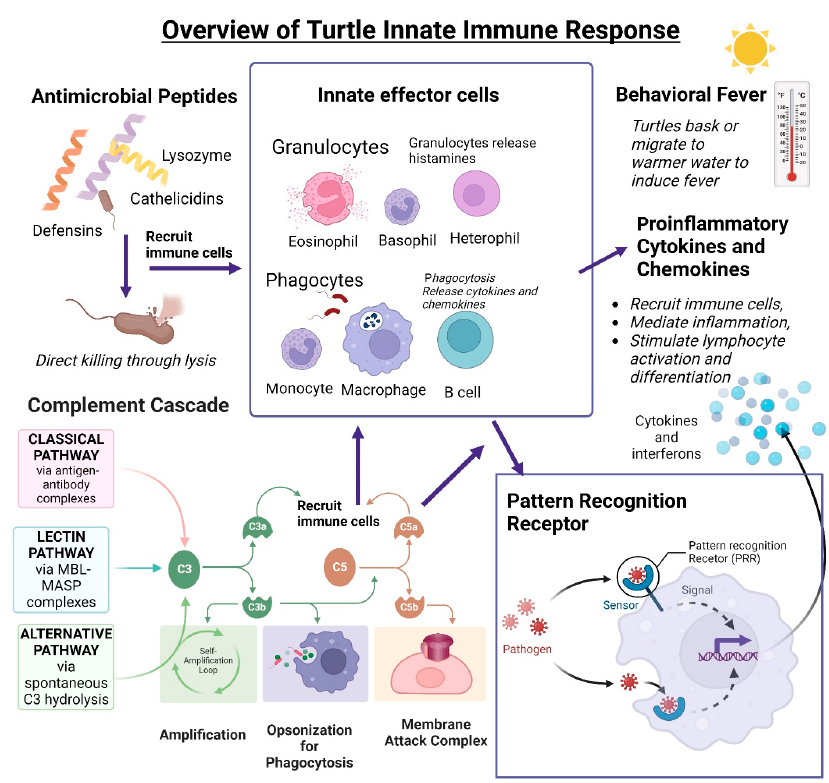
Figure 3. Overview of turtle innate immune functions. Nonspecific innate responses require no previous exposure to microorganisms to ensure a robust response. Antimicrobial peptides (lysozymes, cathelicidins, and defensins) can directly kill microorganisms by cell wall permeabilization and induction of lysis. Innate effector cells include granulocytes and phagocytes. Granulocytes are heterophils, basophils, and eosinophils and can release histamines when activated by microorganisms. Reptiles, including C. mydas , have phagocytic B cells. The complement cascade activates C3 through the classical, lectin, or alternative pathways, which results in the opsonization of microorganisms for phagocytosis or lyse cell wall through the membrane attack complex (MAC) formation. Cleaved C3a and C5a recruit nonspecific effector cells. Innate effector cells recognize microorganisms through the binding of pattern recognition receptors which begins a downstream signaling cascade ending in the release of cytokines and interferons. Cytokines and chemokines can recruit immune cells and mediate inflammation and lymphocyte activation and differentiation. Created using